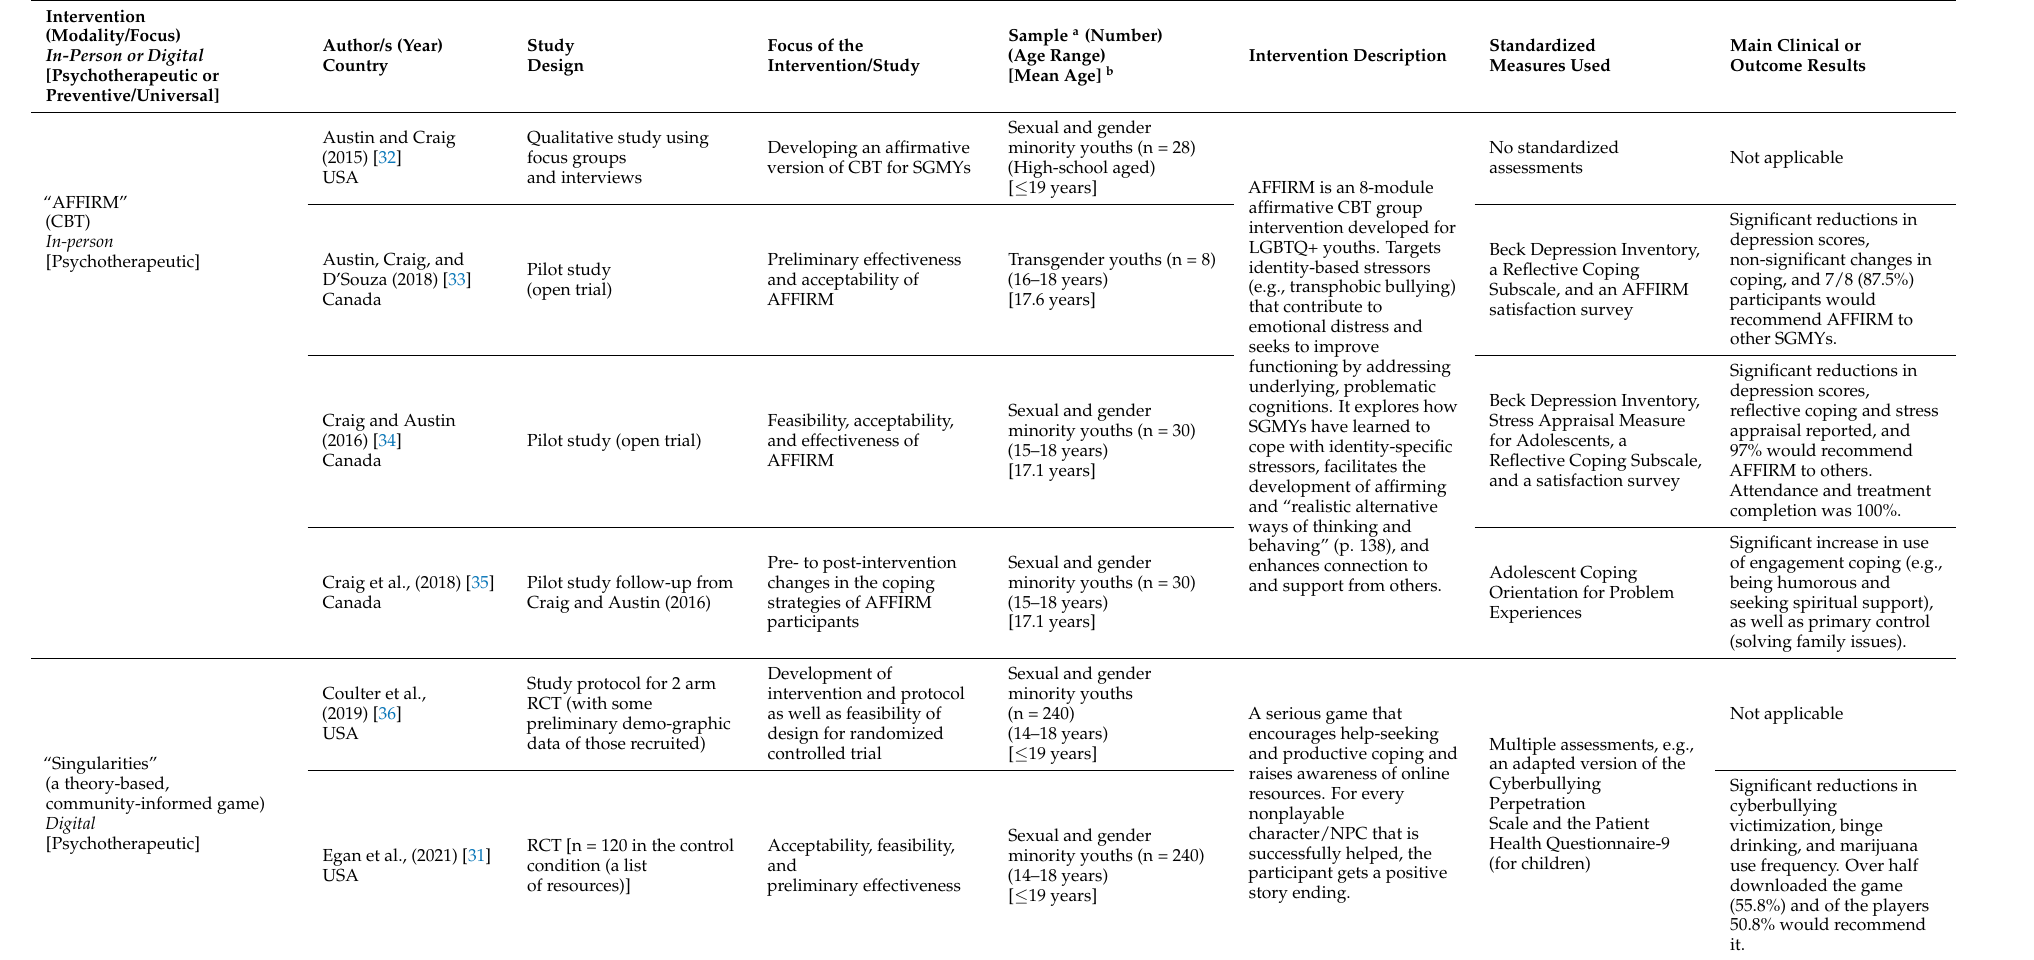
Table 1. Intervention-focused studies (n = 24